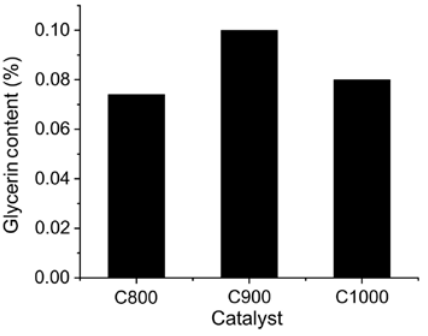
Figure 8: Glycerin content in the biodiesels.